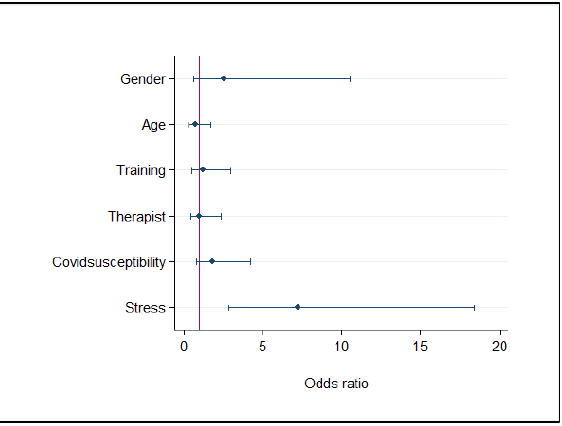
Figure 3. Factors associated to the Summary Index of Unhealthy Days (≤4 vs. >4 days), Multivariable logistic regression model (first interview: n = 130) .